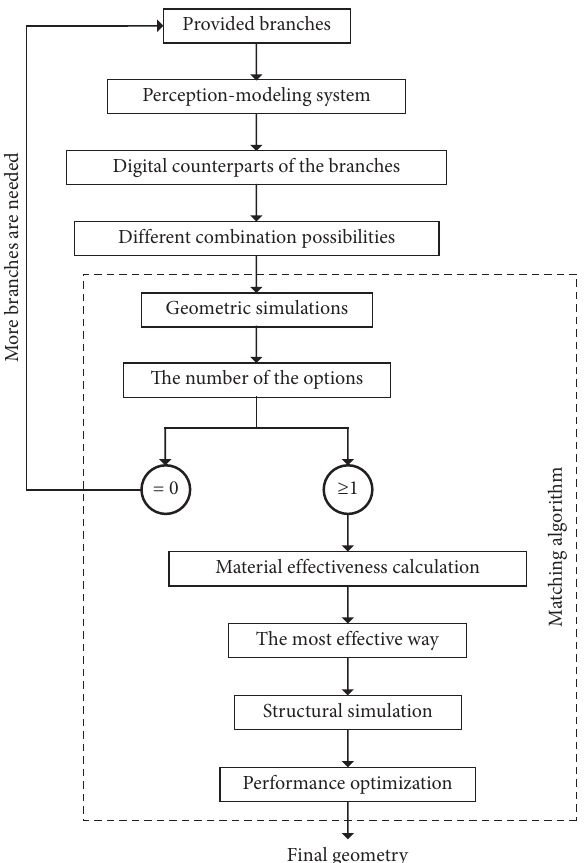
Figure 6: Workflow